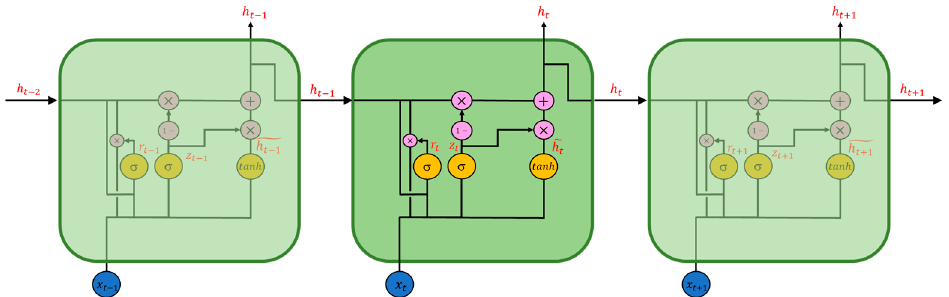
Figure 6. Structure diagram of GRU.